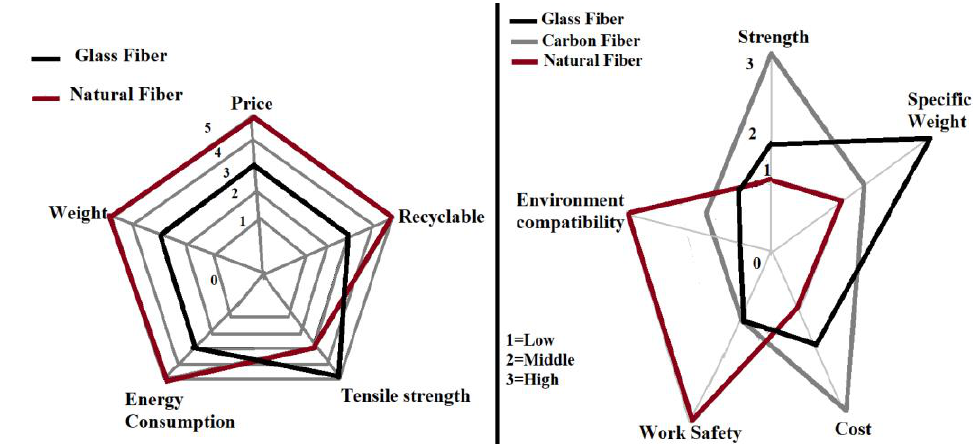
Figure 25. Comparison between natural fibre, glass fibre, and carbon fibre polymer composite. Adapted with permission from Reference [126]. Copyright 2014 John Wiley and Sons.